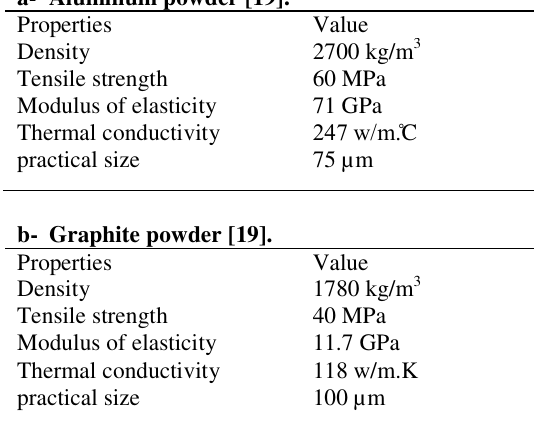
Physical and mechanical properties of filler: